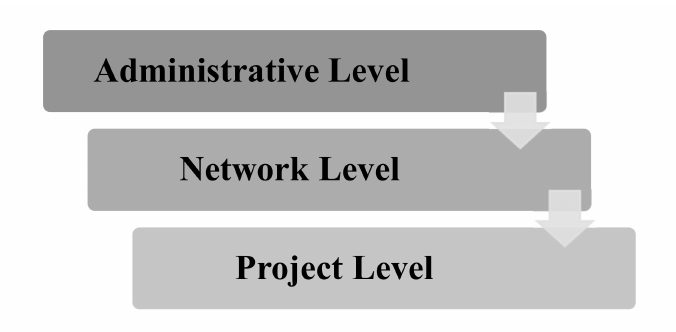
Figure 1. Pavement Management System (PMSs) decision